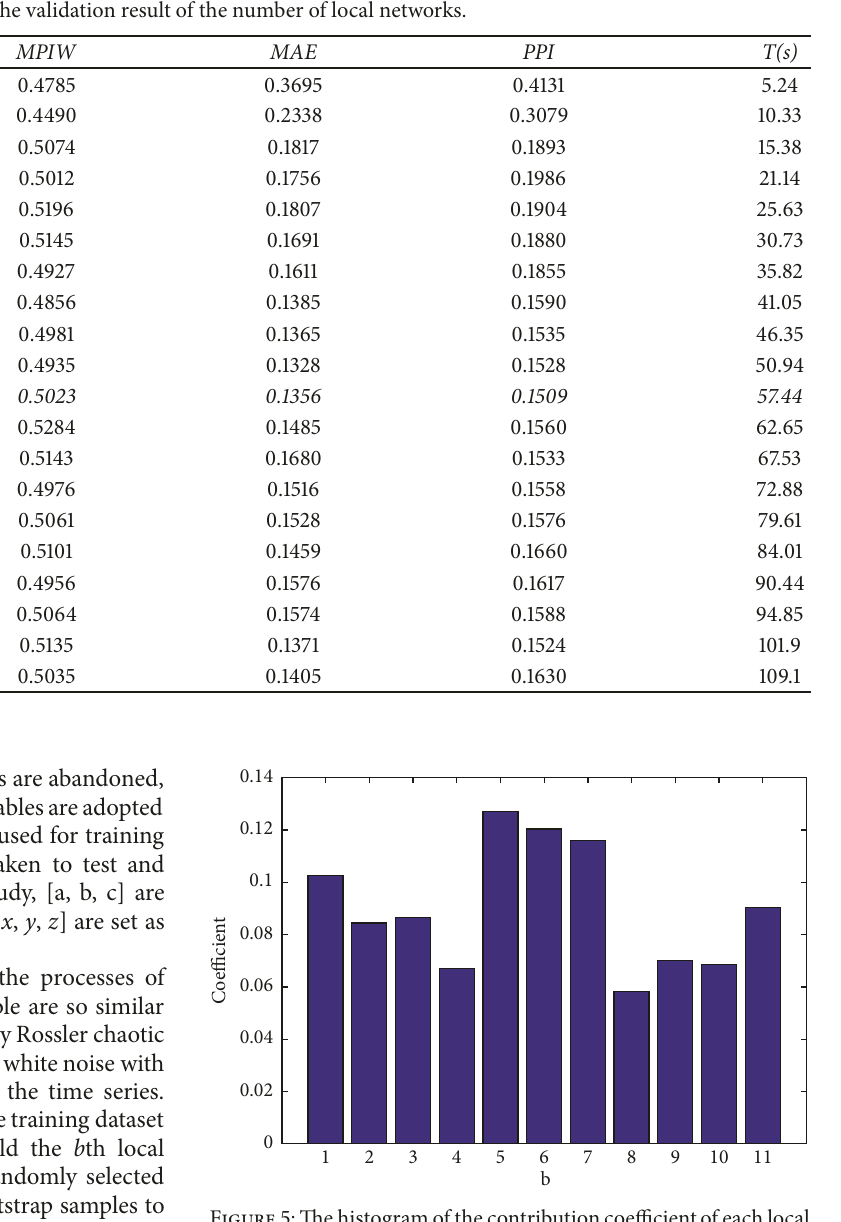
Figure 5: The histogram of the contribution coefficientof each local